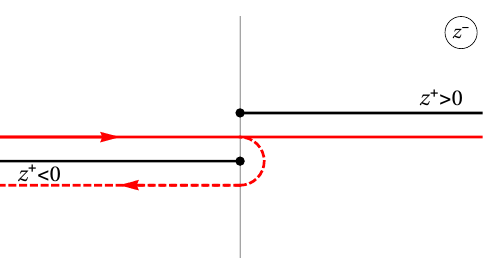
Figure 2 . Analytical structure of the integral (3.2) in the complex plane of z − for the case of DY reaction. The solid red line is the original integration contour. The dashed red line is the modified integration